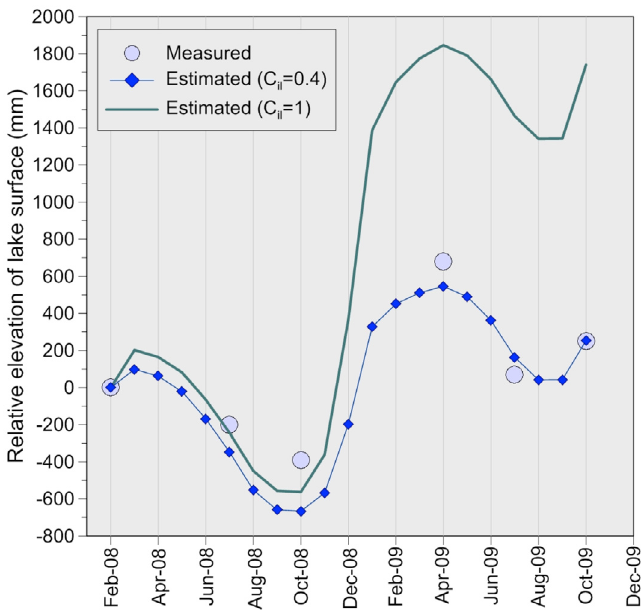
Figure 9. Measured and estimated elevations of Lake Sfondato surface in the period February 2008-October